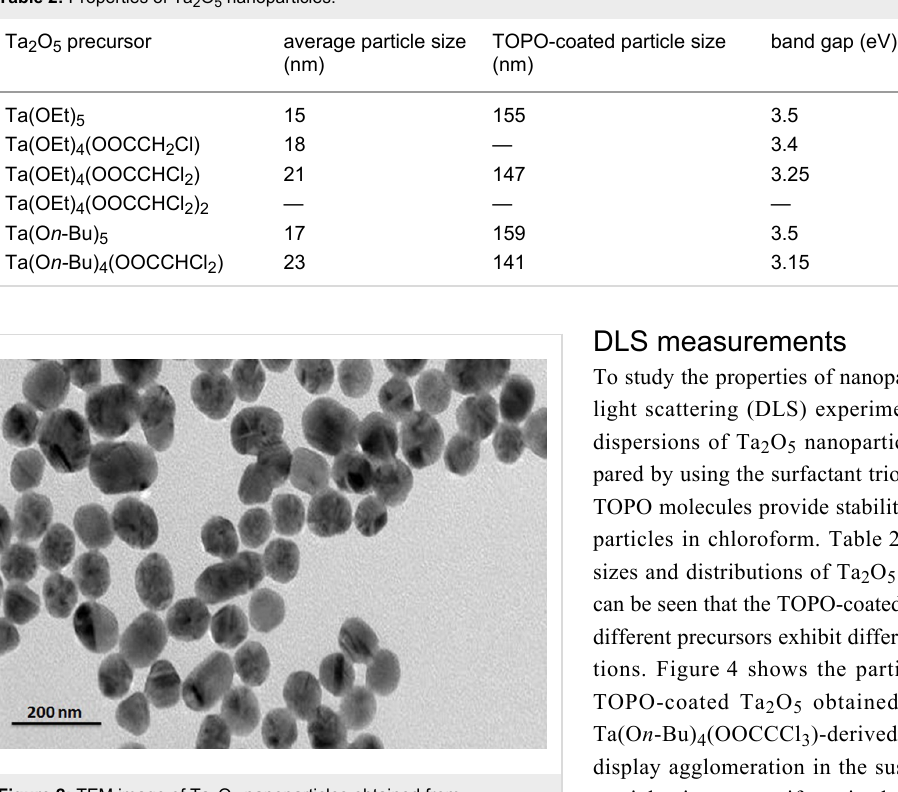
tantalum alkoxides. Ta 2 O 5 nanoparticles synthesized from dichloroacetato tantalum ethoxide are round in shape and their diameter is 150 nm. The diameters of all prepared Ta 2 O 5 nano- particles samples are found to be in the range of 120–170 nm. The oxide nanoparticles are moderately evenly dispersed in all